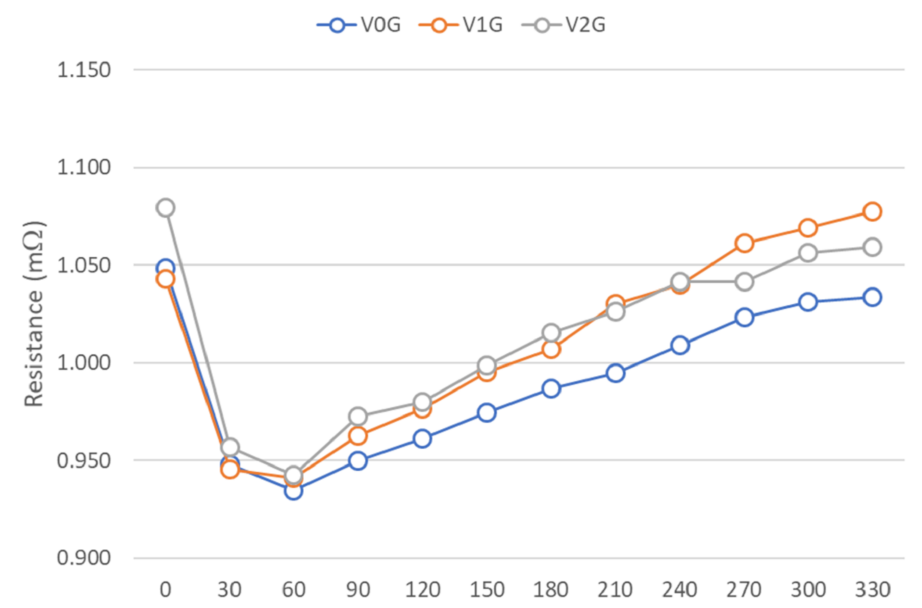
Figure 5. Comparison of DCIR between V0G, V1G, and V2G